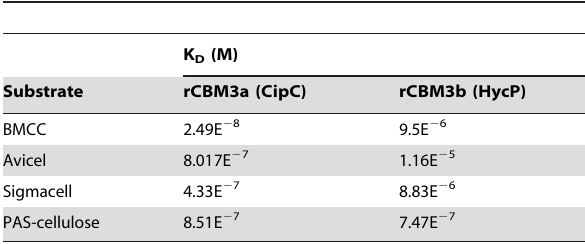
Figure 3. Interactions of rCBM3a and rCBM3b with straw and crystalline cellulose. Recombinant proteins were mixed with substrates during one hour. After centrifugation the bound proteins found in the pellet (P), and the unbound proteins present in the supernatant (S), were analyzed by SDS-PAGE.